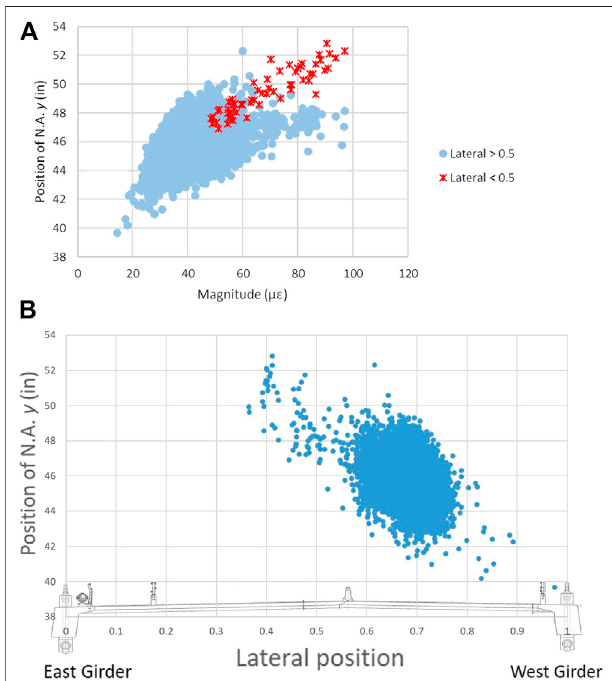
FIGURE 7 | West girder N.A. position at the controlling location (CL) vs (A) Magnitude of the truck weight (summation of the strains measured on the two bottom sensors) grouped based on the proximity to the girder, and (B) Lateral position (strain measured on the bottom of the girder of interest overthesummationofthestrainsmeasuredonthetwobottomsensors)ofthe truck traf fi c.